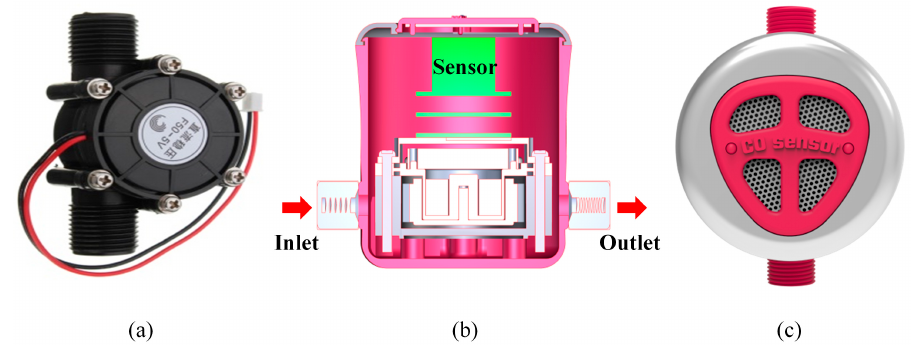
Figure 5. ( a ) A micro-hydropower generator; and ( b ) cross-sectional view and ( c ) top view of the CO sensor without battery (COSWOB).